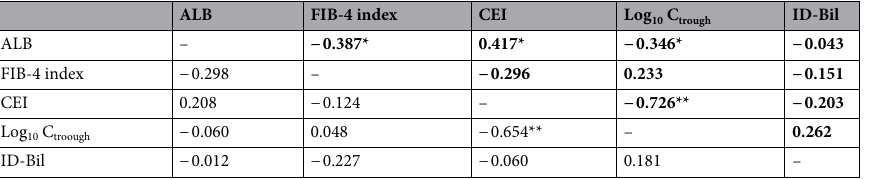
Table 2. Correlation coefficients and partial correlation coefficients between variables. The upper right of the table shows correlation coefficients in bold font, and the lower left shows partial correlation coefficients in normal font. ALB albumin, CEI contrast enhancement index, FIB-4 fibrosis-4, ID-Bil indirect bilirubin, C trough trough concentration of glecaprevir. Asterisks indicate statistically significant differences (* p < 0.05, ** p < 0.001).